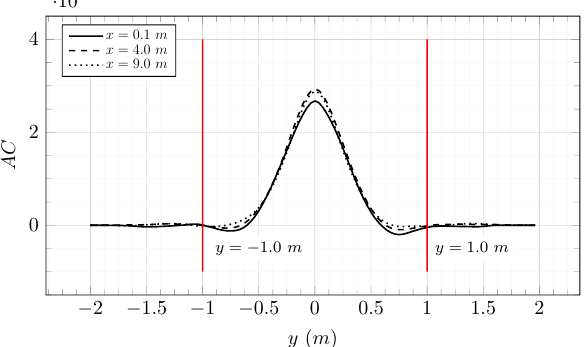
Figure 11. Results of the autocorrelation function applied to the velocity field computed from a LBM- = 8.928 × 10 − 4 m 2 .s − 2 . x is the distance from LES simulation using DFSEM with L = 1.0 m and u (cid:48) 2 i the inlet of the LBM domain. y is the distance from the centre of the domain in the span-wise direction. The integral length scale of turbulent structures generated by the DFSEM boundary length L .